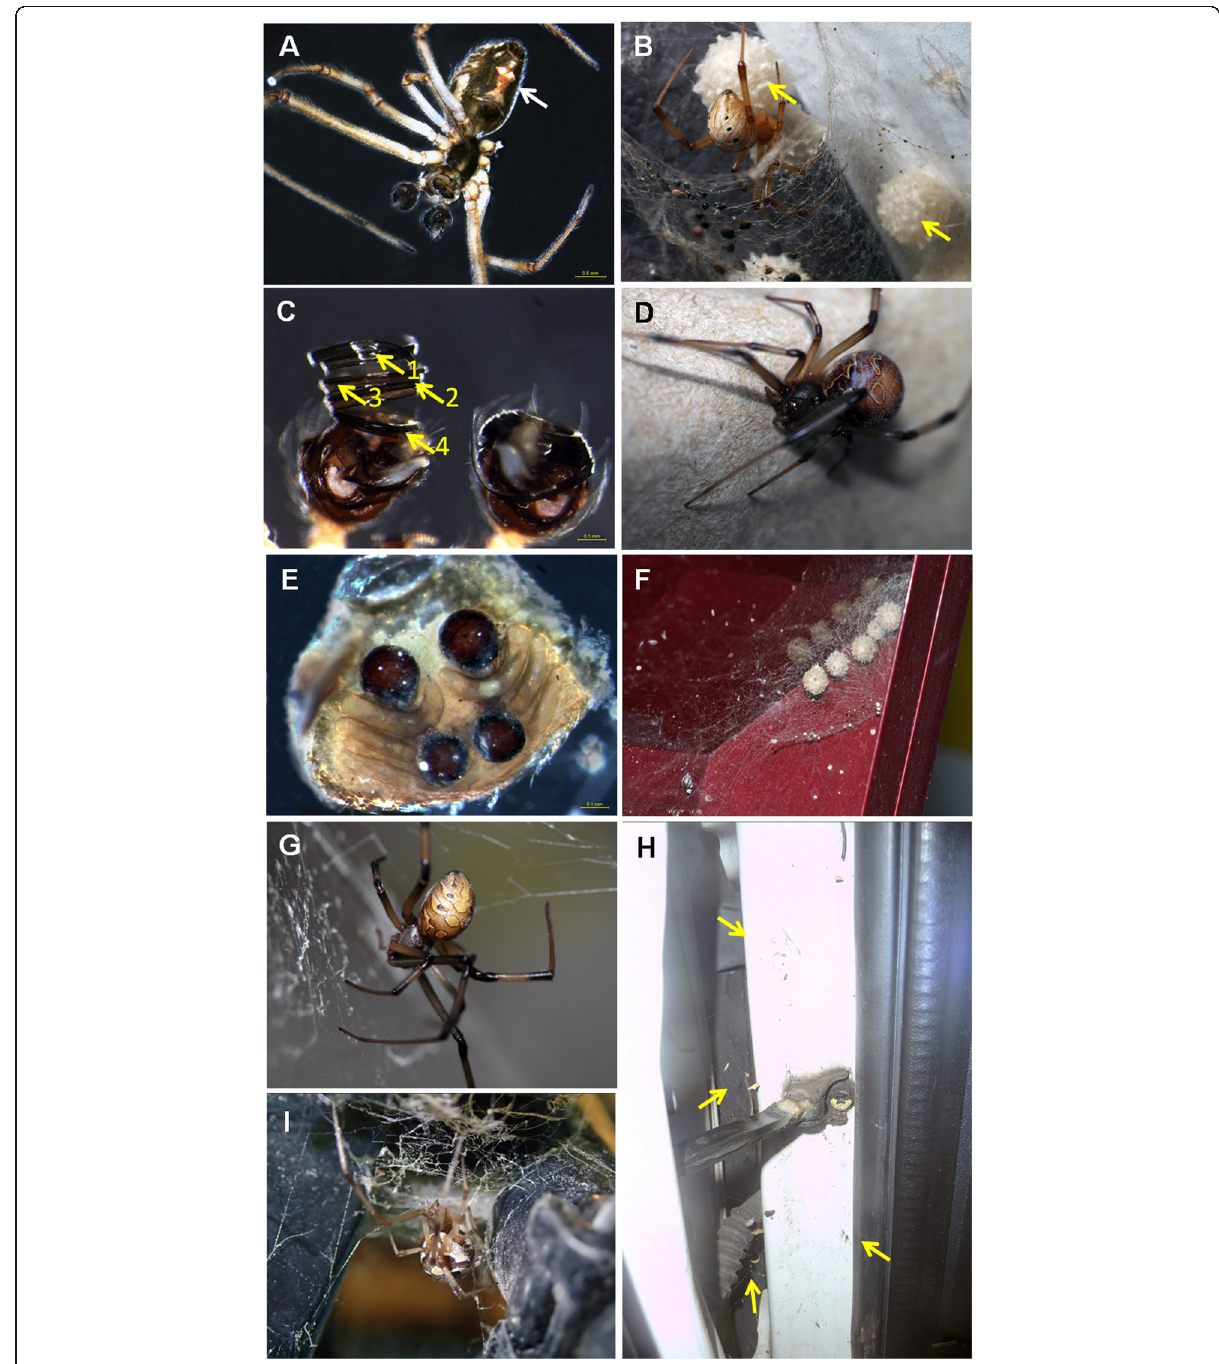
Figure 2 Common morphological characteristics of Latrodectus geometricus according to Koch (1841). (A) The hourglass-shaped streak on the underside of the abdomen (male, Johor, Malaysia). (B) Dome-shaped abdomen typical of a juvenile Theridiidae and the spiky spherical egg sacs (Penang, Malaysia). (C) Embolus inside the palp of the male spider showing four coils. (D) A brown widow caught in central Peninsular Malaysia bearing darker and more spherical features on its abdomen. (E) The epigynum, characteristic of females, with two pairs of spermathecae located on the underside of the abdomen. (F) Spiky spherical egg sacs lined in a row on a window sill of a house (Penang, Malaysia). (G) The dome-shaped abdomen of a female brown widow from the northwest of Peninsular Malaysia bearing lighter features on its abdomen. (H) Egg sacs, moulted skin and live and dead juvenile/adult L. geometricus (yellow arrows) being surrounded by its cobweb. (I) Dorsal aspect of abdomen with distinct pattern surrounded by cobweb, found in and around bicycle